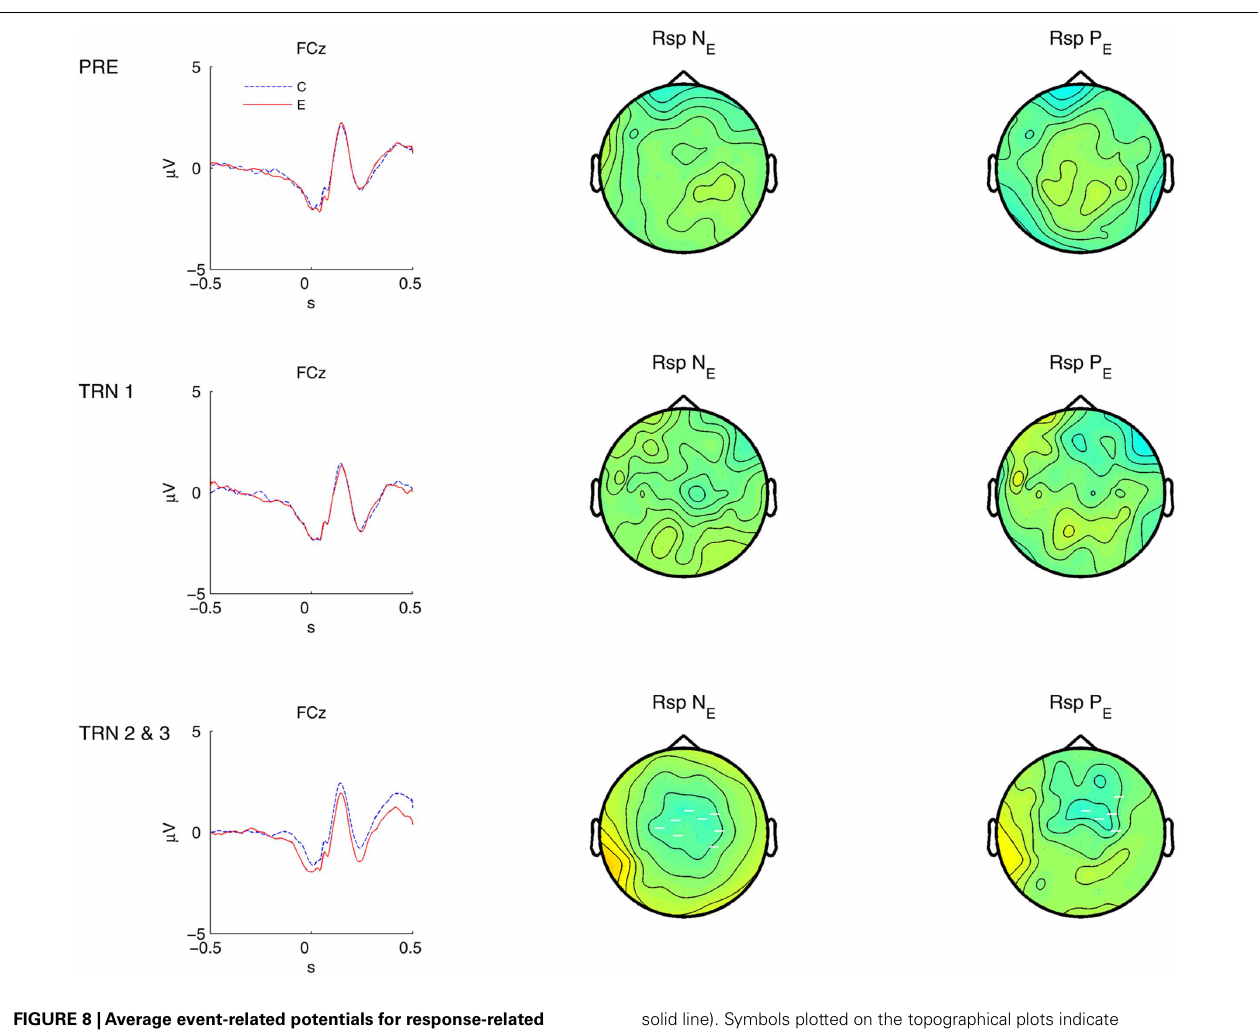
FIGURE 8 |Average event-related potentials for response-related activity. Trace plots indicate average voltage (in μ V) over time at FCz/8; correct classification = C (blue, dotted line), error classification = E (red,